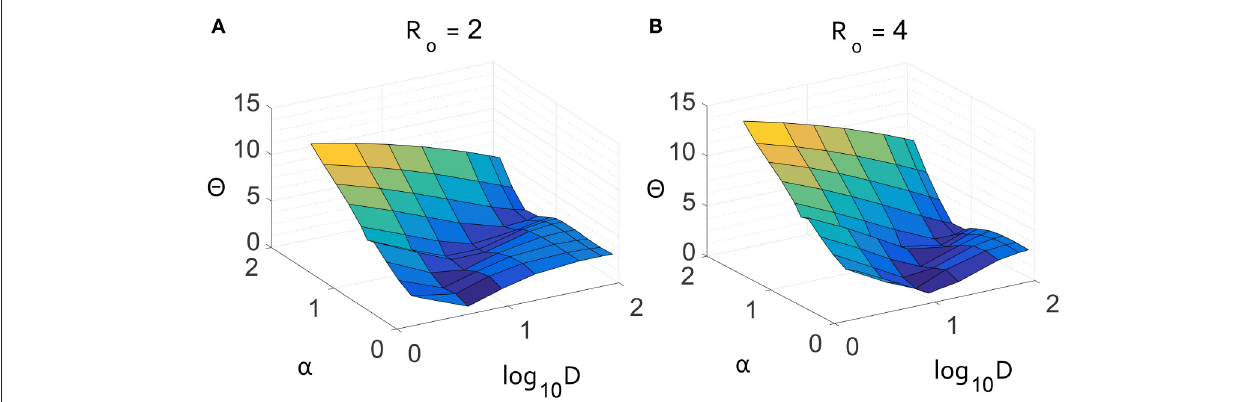
FIGURE 5 | Result of parameter scan through α and D displaying the absolute distance 2 between the growth curves for average number of infected. The two panels show the difference for constant values of (A) R 0 = 2 and (B) R 0 = 4. These scans show that there is an optimal value of α that nearly matches the air travel model for both values of R 0